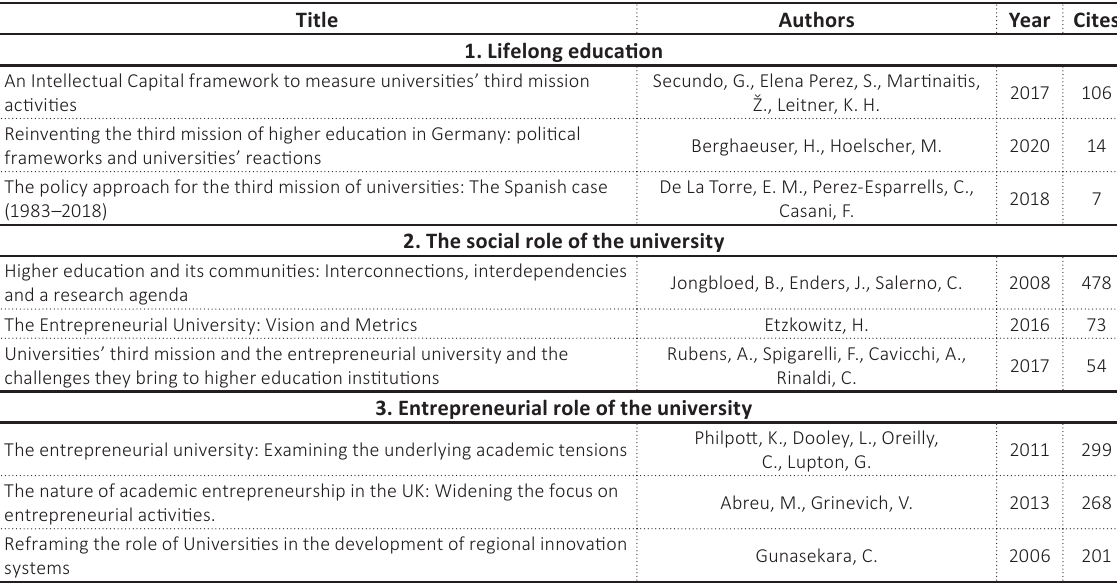
Table 3. Top-3 most cited publications on the third mission of the university